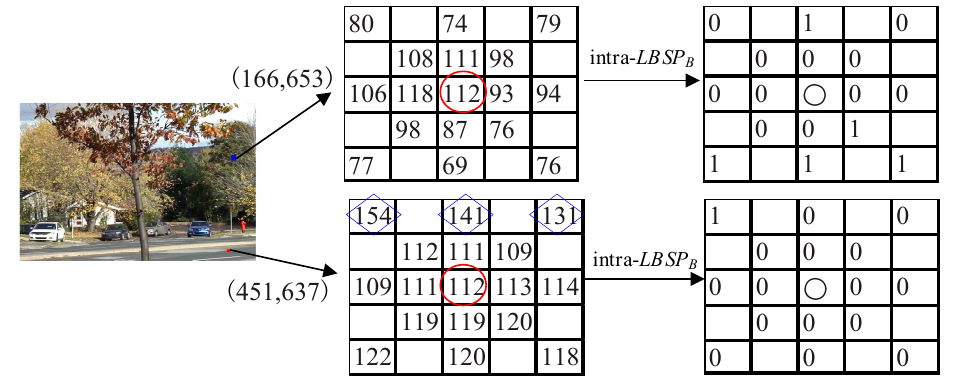
Figure 6. Comparison of intra-LBSP features of two pixels on blue channel. The pixel (451,637) was located in the static region and the pixel (166,653) was located in the dynamic region.